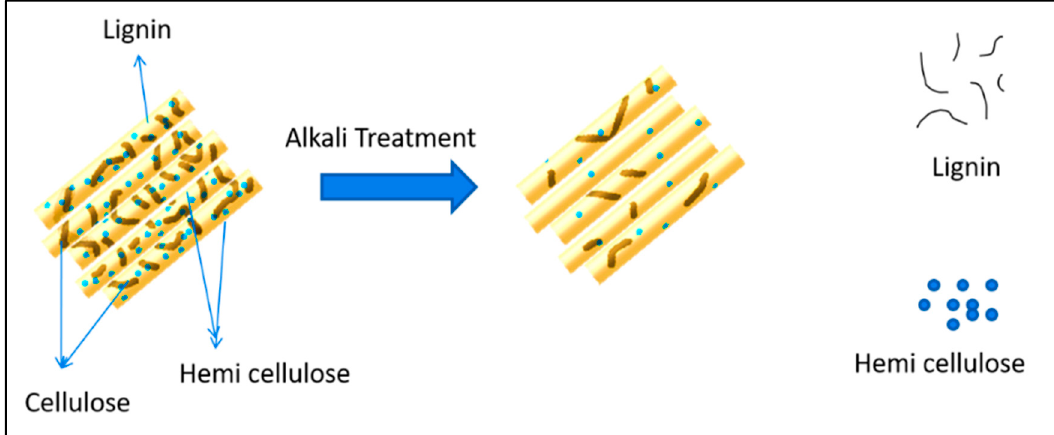
Figure 2. Schematic representation of alkali treatment of secondary wall of